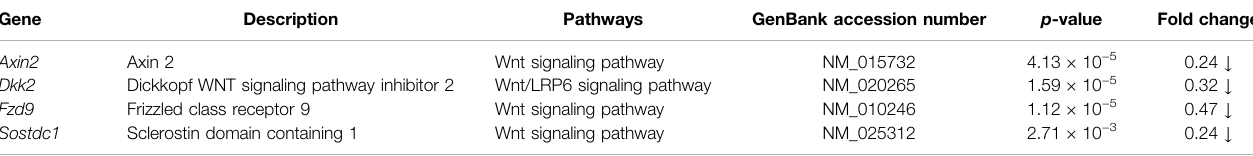
TABLE 4 | Selected differentially regulated Wnt signaling genes upon vibration treatment in MC3T3-E1 cells under estrogen-free conditions. Gene